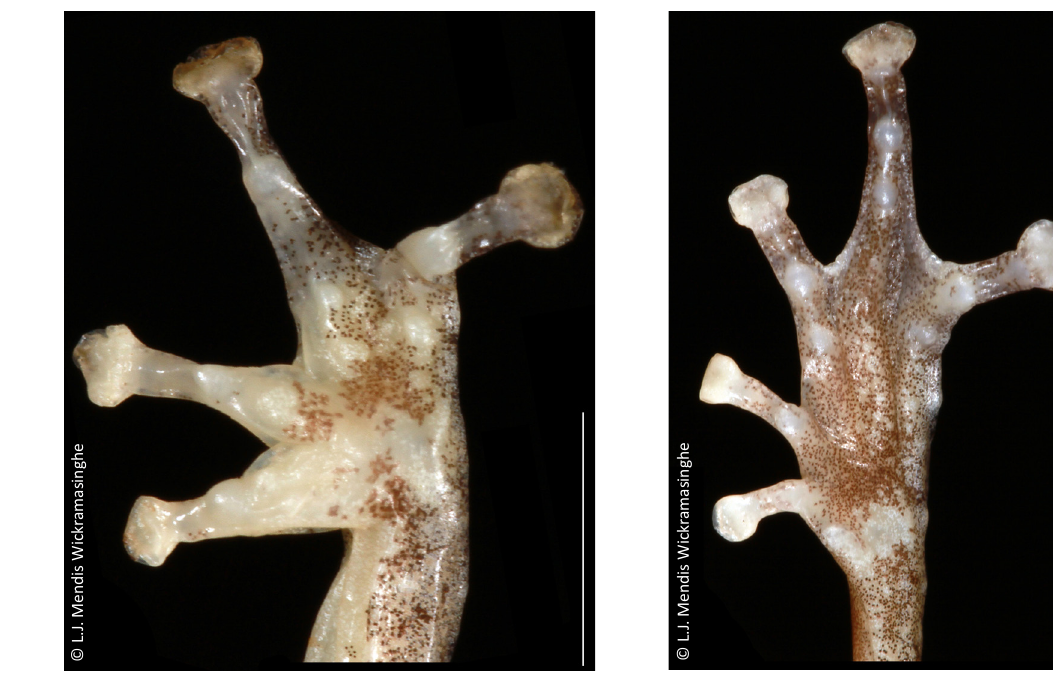
Image 4. Pseudophilautus dilmah sp. nov. holotype male (NMSL